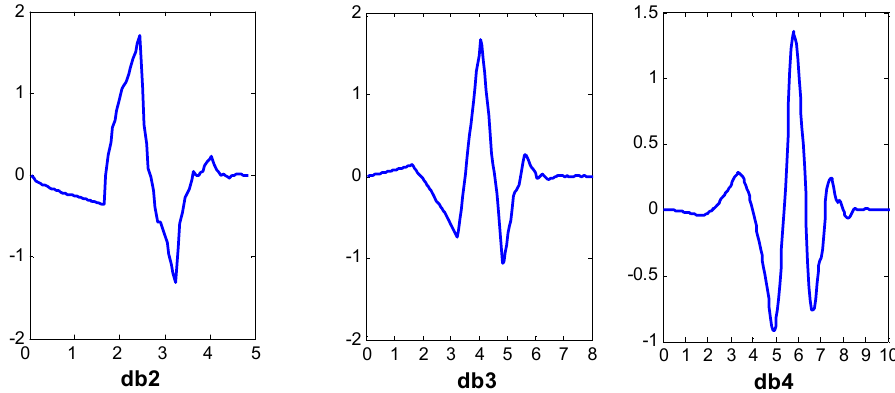
R ) at the Earth's n